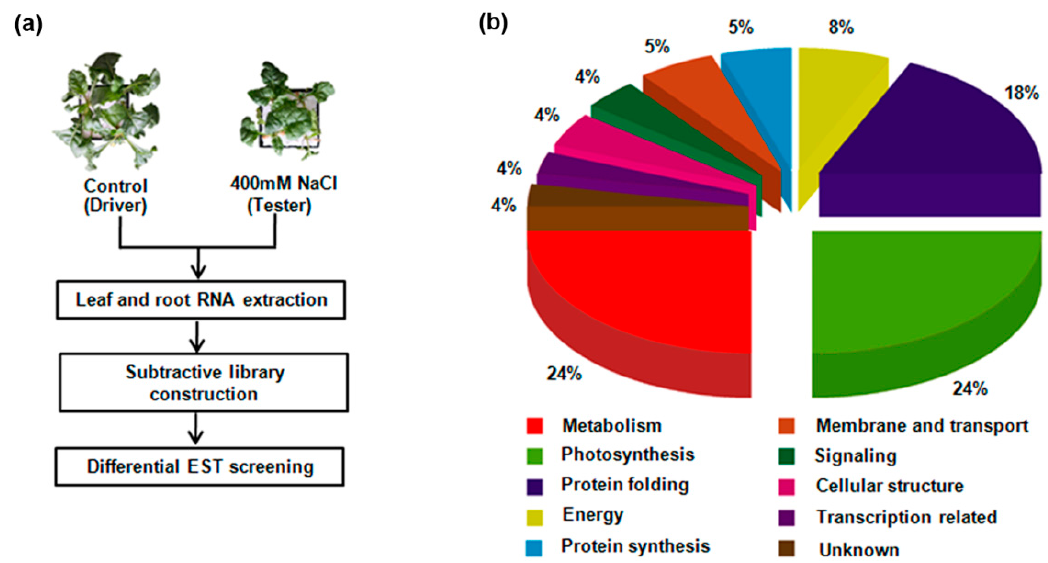
Figure 1. Experimental scheme of screening differentially expressed genes by suppression subtractive hybridization (SSH) and functional classification of the identified genes using the UniProt database. ( a ) Experimental scheme; ( b ) Functional classification of the differential genes; EST stands for expressed sequence tag.